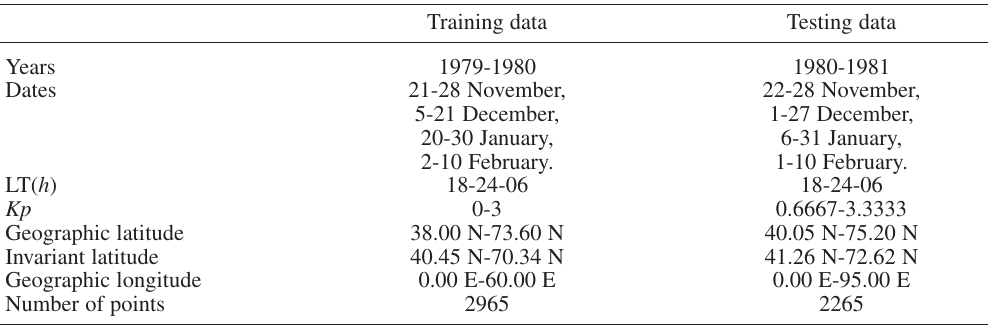
Table 3.III. Data coverage for the training and testing of the METU-NN for trough